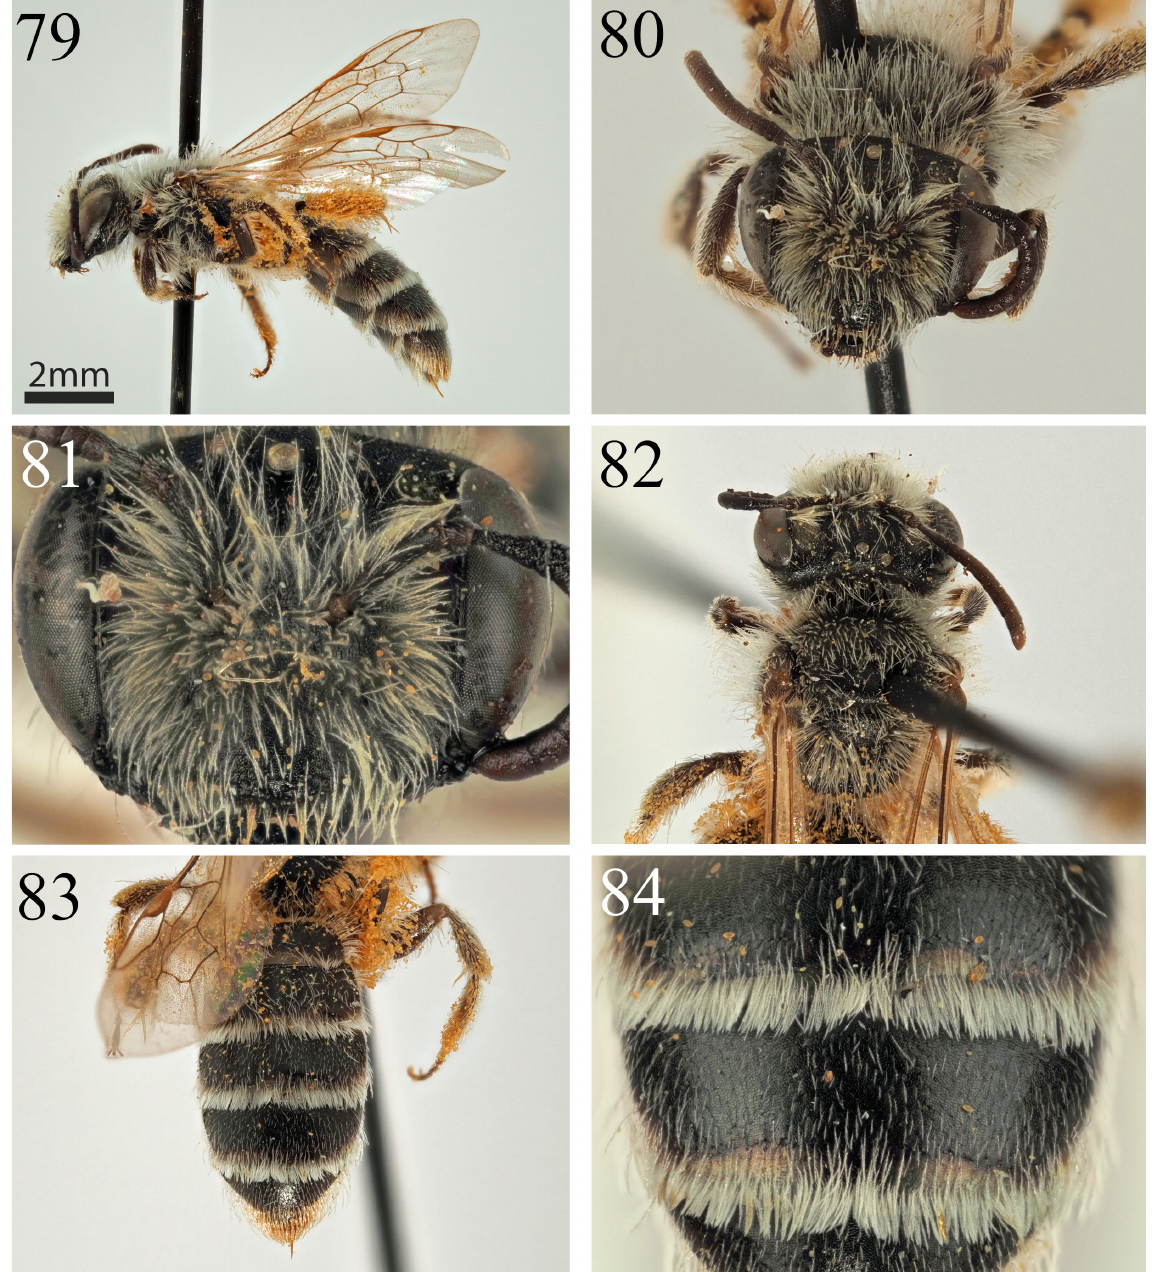
Figs 79–84. Andrena idigna Wood sp. nov., ♀ (OÖLM). 79 . Profile. 80 . Face. 81 . Face, detail. 82 . Dorsum. 83 . Terga. 84 . Terga,